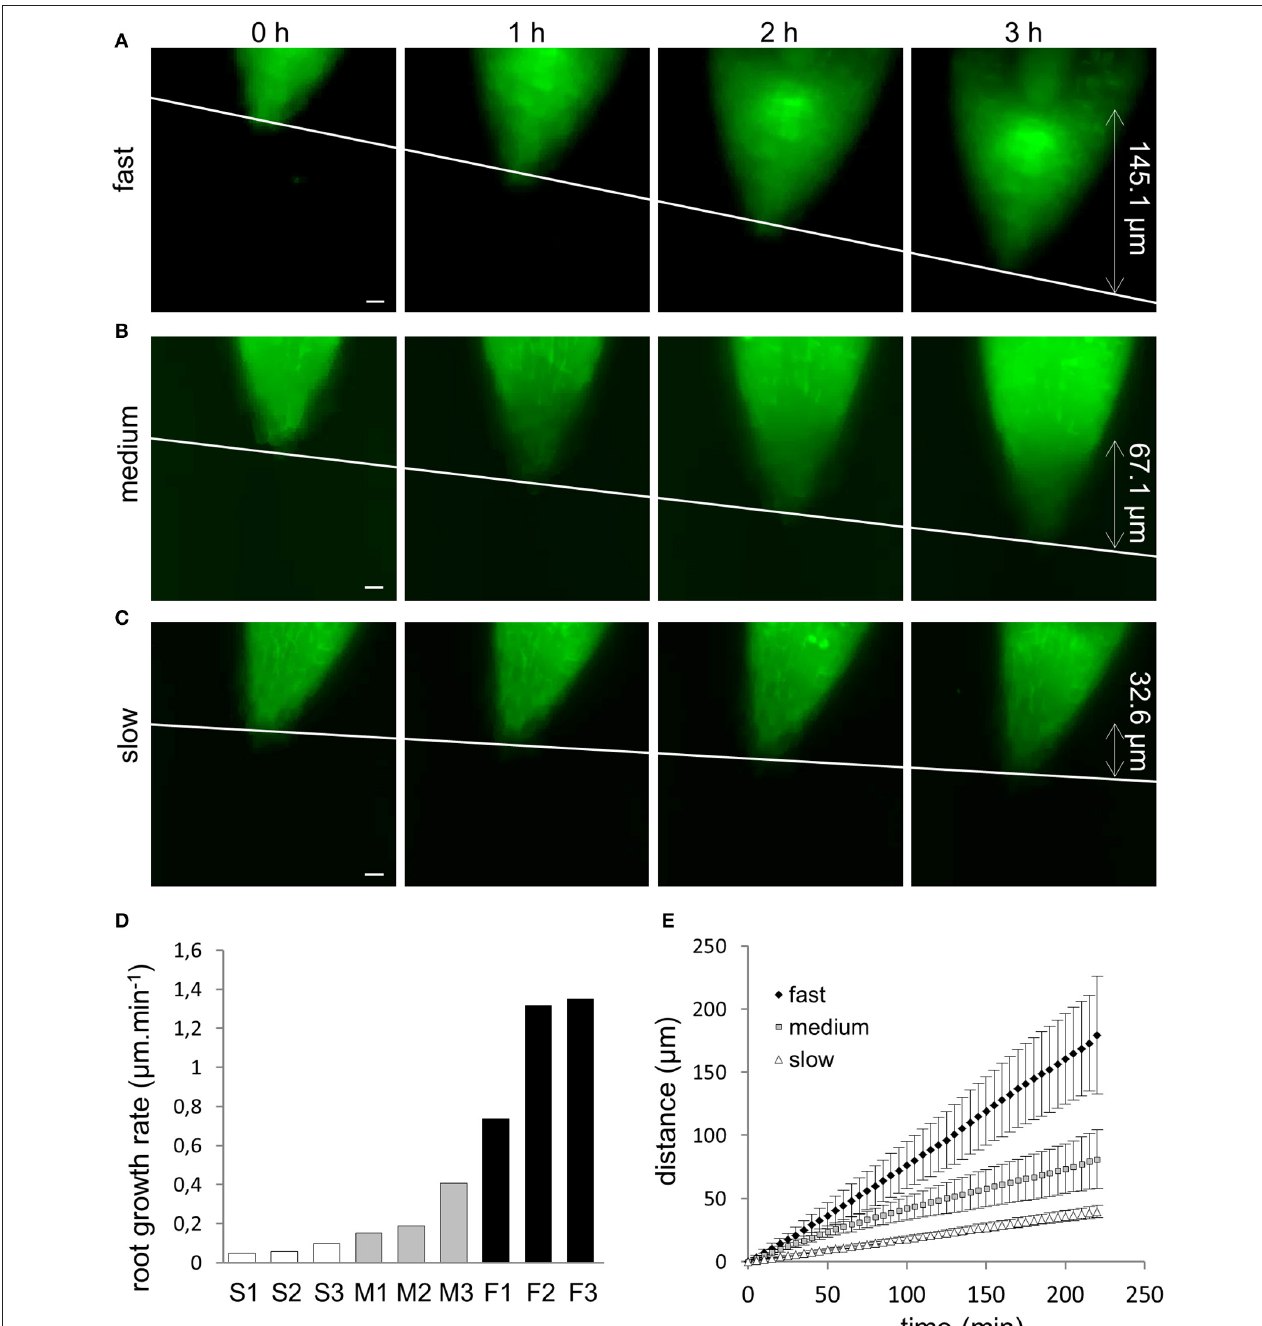
FIGURE 1 | Root growth rate of Medicago sativa somatic embryo-derived plantlets, expressing 35S::GFP:MBD construct. (A–C) Light-sheet microscopy imaging of root growth over the period of 3h. Based on the root growth rate, roots were sub-divided into three different groups. Representative examples of a fast-growing root, grown in a distance of 145.1 µ m in 3h (A) , a medium-growing root, grown in a distance of 67.1 µ m in 3h (B) and a slow-growing root, grown in a distance of 32.6 µ m in 3h (C) . Double-pointed arrows with appropriate values on the right side of images show recorded distance in µ m. White line indicates displacement of the root tip in individual time points of the measurement. (D) Bar chart illustrating distribution of measured individual roots according to their root growth rate. White bars represent slow-growing roots (S1, S2, S3), gray bars represent medium-growing roots (M1, M2, M3) and black bars represent fast-growing roots (F1, F2, F3). (E) Time course of primary root growth showing a correlation between average length increase of fast-growing ( (cid:7) ), medium-growing ( (cid:3) ) and slow-growing ( 1 ) roots and recording time from time-lapse light-sheet imaging at 5min intervals. Bars = 20 µ m (A–C) .